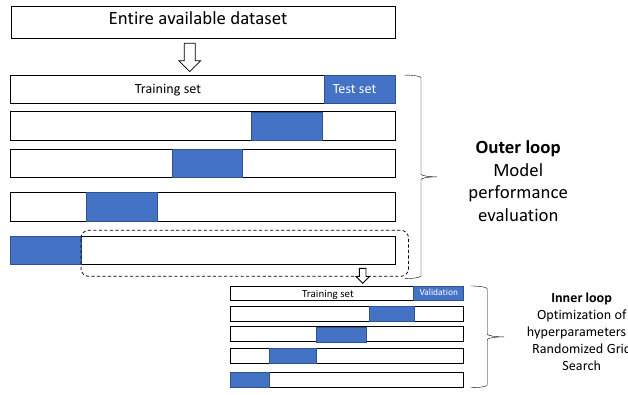
Figure 10. Nested cross-validation—illustration